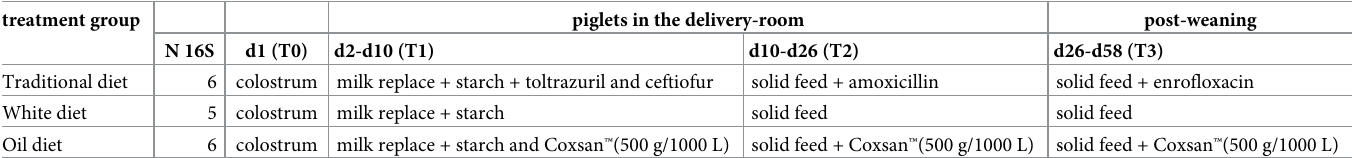
Table 6. Sample size, diets and treatments (feed supplements) for the piglets selected for sequencing from the three experimental groups. From all pigs rectal samples were collected at day 1, 12, 26 and 58 for 16S rRNA-gene sequencing. treatment group piglets in the